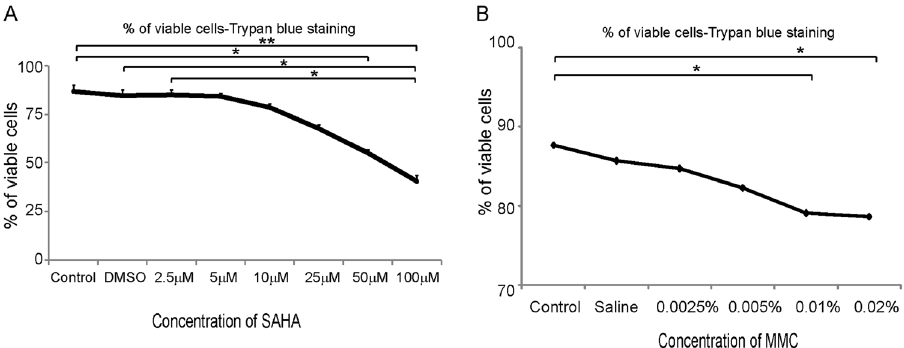
Figure 1. Dose dependent effect of SAHA and MMC on cell viability. Trypan blue cell viability assay of cultured day 14 differentiated human limbal epithelial cells to corneal epithelial cells treated with different concentrations of SAHA ( A ) and MMC ( B ) (n = 4). Statistical significance based on one way ANOVA test denoted by *p ≤ 0.05, **p ≤ 0.01, ***p ≤ 0.001, was calculated in presence of SAHA and MMC in comparison to untreated cultured cells by using statistical software GraphPad PRISM Ver